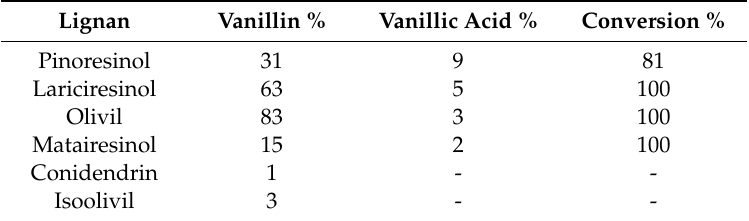
Table 2. Results of nitrobenzene-mediated oxidative degradation of lignans. Lignan Vanillin